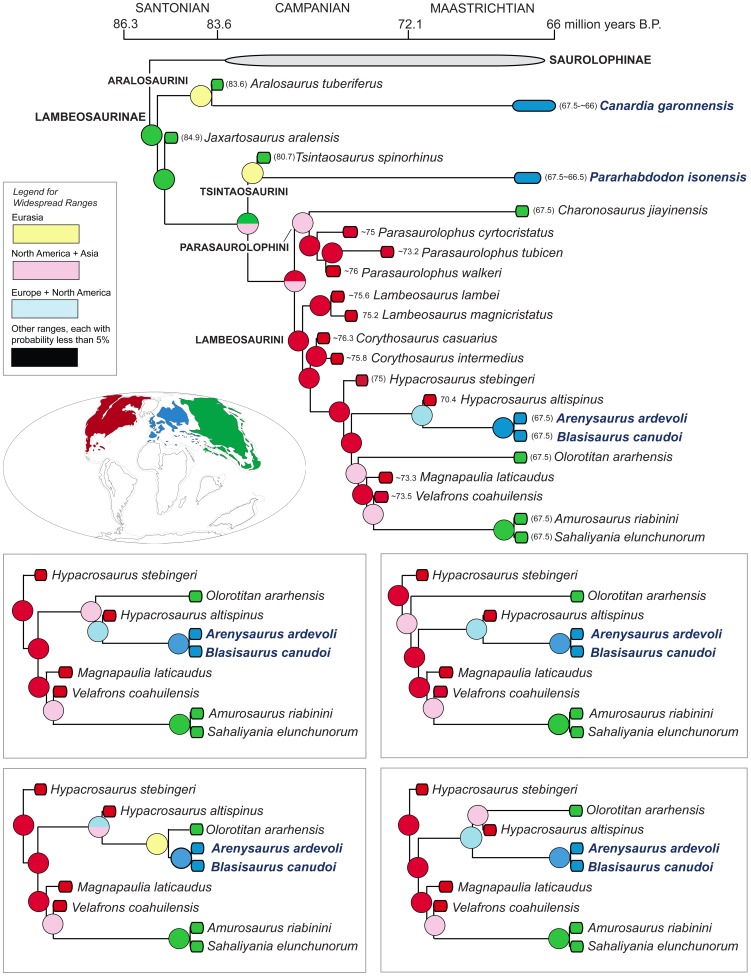
Time-calibrated phylogram of Lambeosaurinae based on the phylogenetic hypothesis shown in Fig.
25. Each of the five most parsimonious trees resulting from parsimony analysis is shown. However, because those trees differ only in the relationships of the Hypacrosaurus-Amurosaurus clade, we only show the complete topology of one of the threes and include below only the topologies of that subclade for the additional four most parsimonious trees. The circles at each node represent the relative probabilities for the ancestral areas inferred using Statistical Dispersal-Vicariance Analysis (S-DIVA [104]), implemented in RASP 2.0b [127]. The numbers to the left of the taxon names are datings in millions of years. When absolute dating estimates are not available but only subages (e.g., late Maastrichtian), the absolute dating of the taxon is approximated as the mid-point of the available range (numbers between brackets). The literature sources for each taxon’s geochronological range are as follows: Amurosaurus riabinini (late Maastrichtian range for the Udurchukan Formation [64]); Aralosaurus tuberiferus (late Santonian-early Campanian range for the Bostobe Formation [43]); Arenysaurus ardevoli and Blasisaurus canudoi (late Maastrichtian; Fig. 2); Charonosaurus jiayinensis (late Maastrichtian range for the Yuliangze Formation [60]); Canardia garonnensis (late Maastrichtian up to near the K-Pg boundary; Fig. 2); Corythosaurus spp., Lambeosaurus spp., and Parasaurolophus walkeri
[98]; Hypacrosaurus altispinus
[49]; H. stebingeri (‘middle’ to late Campanian range for the upper section of the Two Medicine Formation [1]); Magnapaulia laticaudus
[131]; Jaxartosaurus aralensis (Santonian range for the Syuksyuk Formation [132]); Olorotitan arharensis (late Maastrichtian range for the Udurchukan Formation [6]); Pararhabdodon isonensis (late to latest Maastrichtian; Fig. 2); Parasaurolophus tubicen and P. cyrtocristatus
[133]; Sahaliyania elunchunorum (late Maastrichtian range for the Yuliangze Formation according to Godefroit et al. 2008); Tsintaosaurus spinorhinus (early Campanian range for the Jingangkou Formaton [134]); and Velafrons coahuilensis
[135]. Datings for age boundaries are from Walker et al. [136].